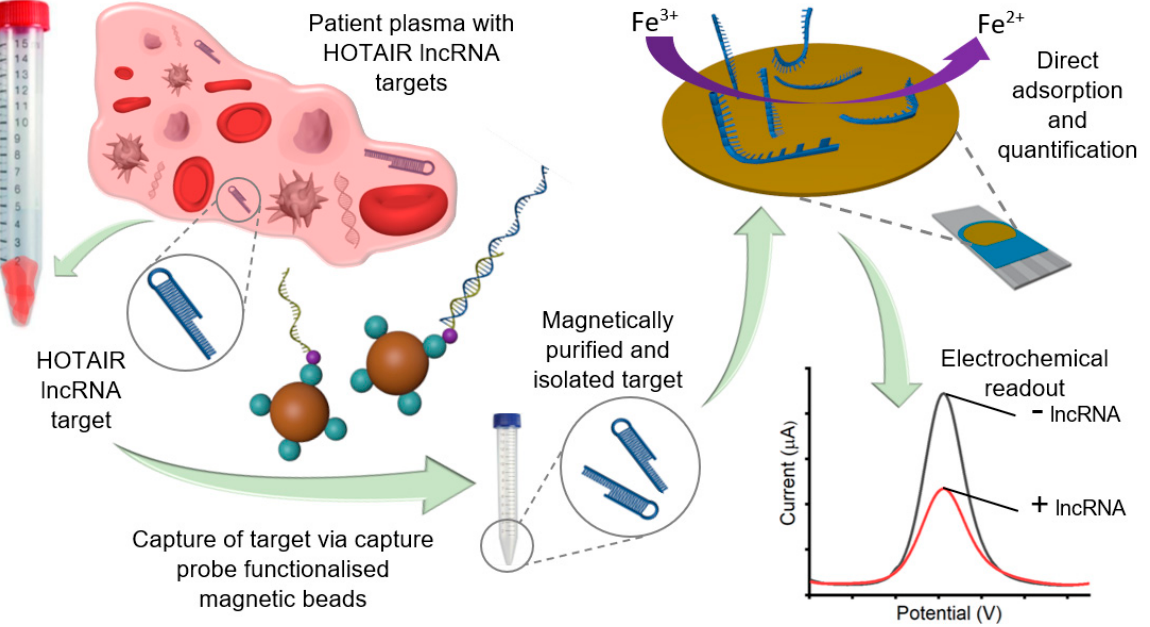
Figure 1. Schematic representation of the detection of HOTAIR lncRNA with the [Fe(CN) 6 ] 3 − /4 − redox system for DPV readout. Magnetic nanoparticles functionalized with complimentary capture probe sequences were added to total extracted RNA samples containing HOTAIR lncRNA targets. After hybridization of HOTAIR targets and capture probes, the capture probe/nanoparticle/target complex was magnetically washed for HOTAIR target purification. HOTAIR lncRNA targets were isolated from the capture probe/nanoparticle complexes via heat release denaturation. HOTAIR targets were then collected and directly adsorbed at the unmodified SPE-Au surface for 30 min via the gold-RNA affinity interaction, before voltametric interrogation with [Fe(CN) 6 ] 3 − /4 − redox couple for generating the DPV